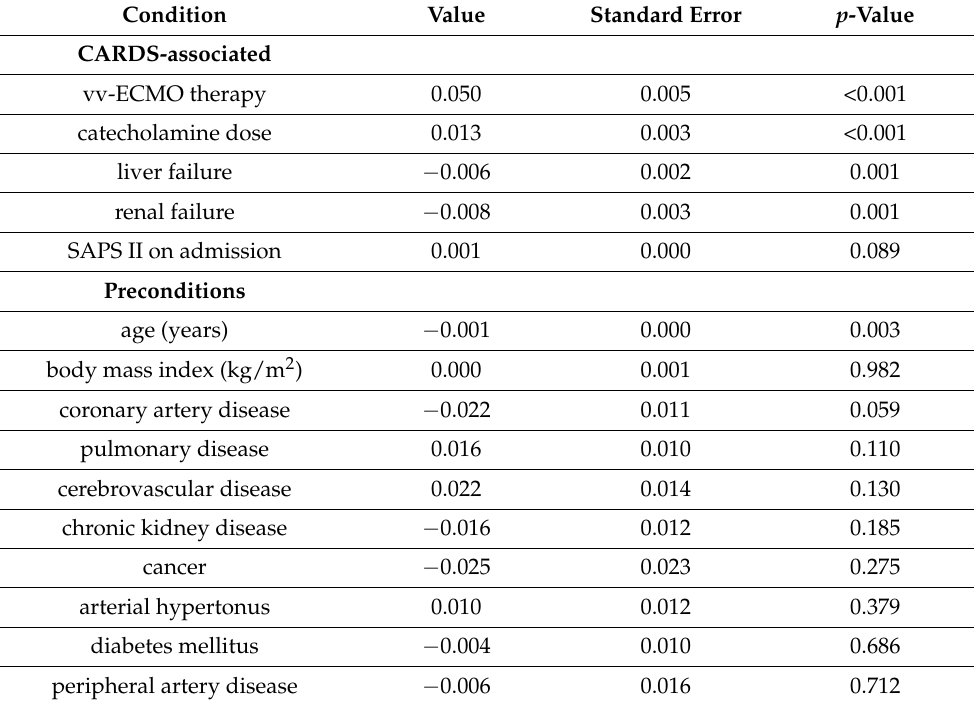
Table 2. Linear regression for sedative dosages and CARDS associated conditions as well as